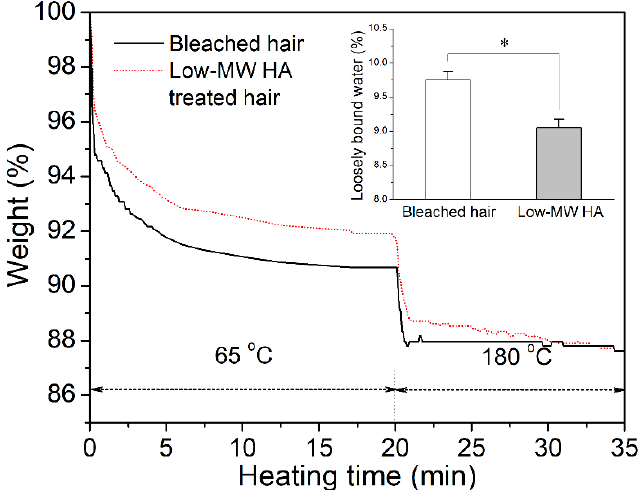
Figure 5. TGA spectra of untreated bleached hair and low-MW HA-treated hair. Inset: average loosely bonded water content in the HA-treated hair and untreated bleached hair. (Significance: * p < 0.05 vs. bleached hair. N = 4).